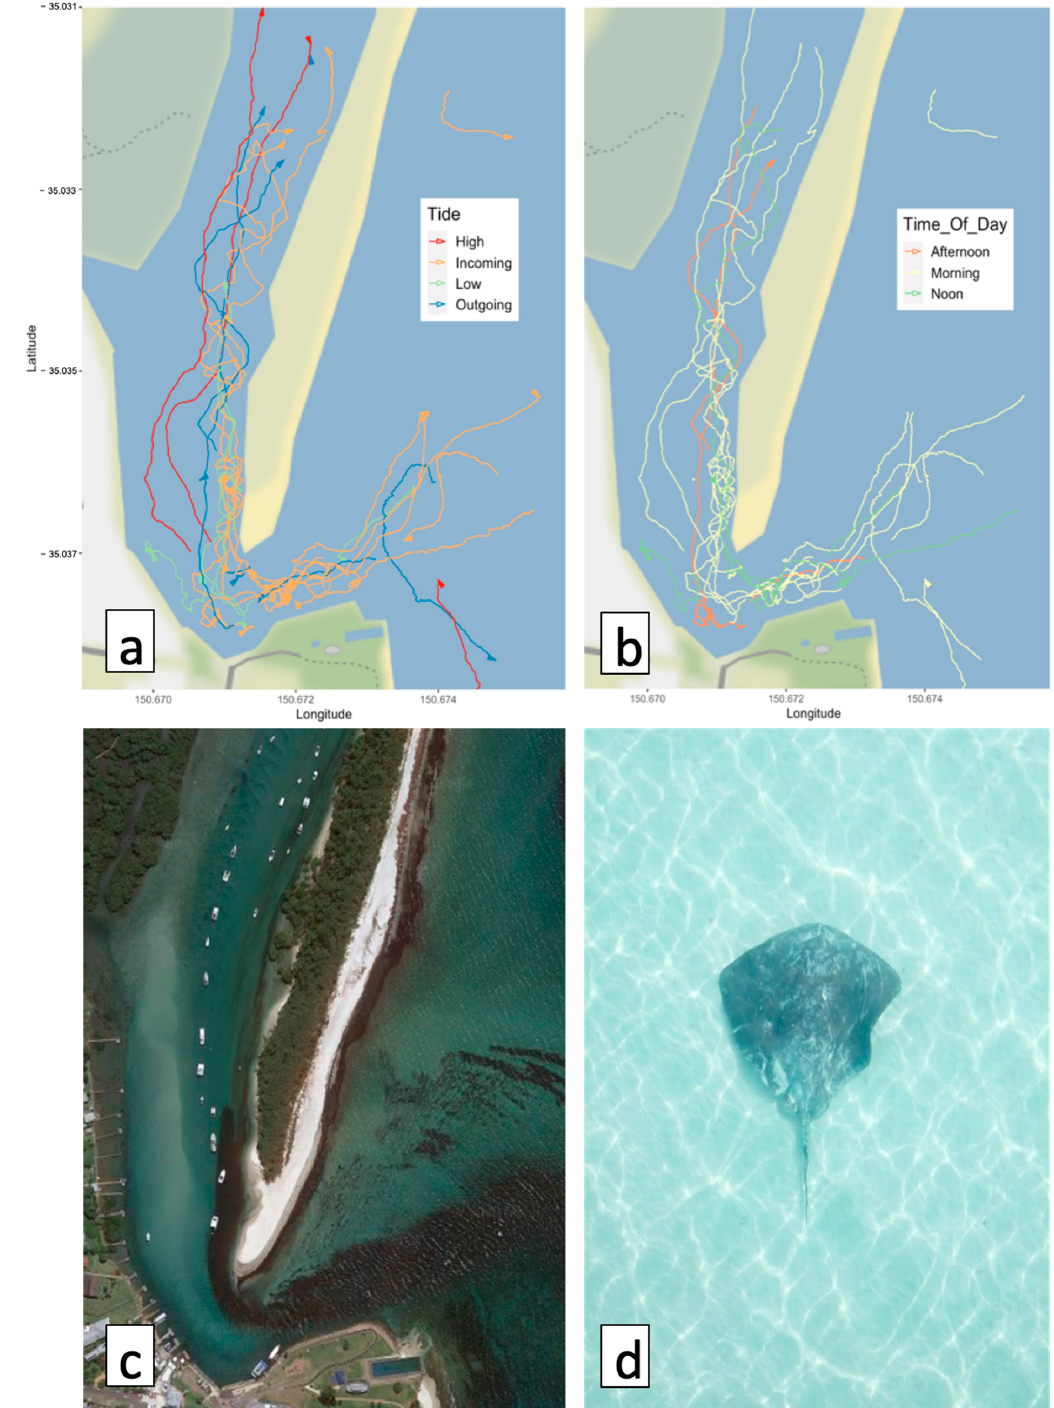
Figure 5. Tracks of short-tail stingrays, plotted according to tide ( a ) and time of day ( b ), overlayed on Currambene Creek, Jervis Bay. Arrows indicate the direction of the track. ( c ) Satellite image displaying the bathymetric layout of this location (Google Earth Version 9.120.0.2). ( d ) Image of one of the short-tail stingrays tracked.